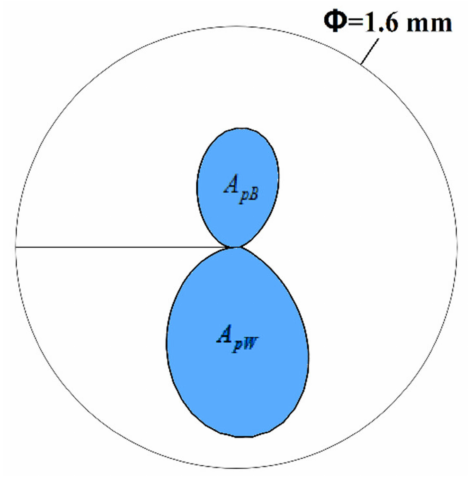
Figure 3. Diagram of plastic zone area of the base metal and weld